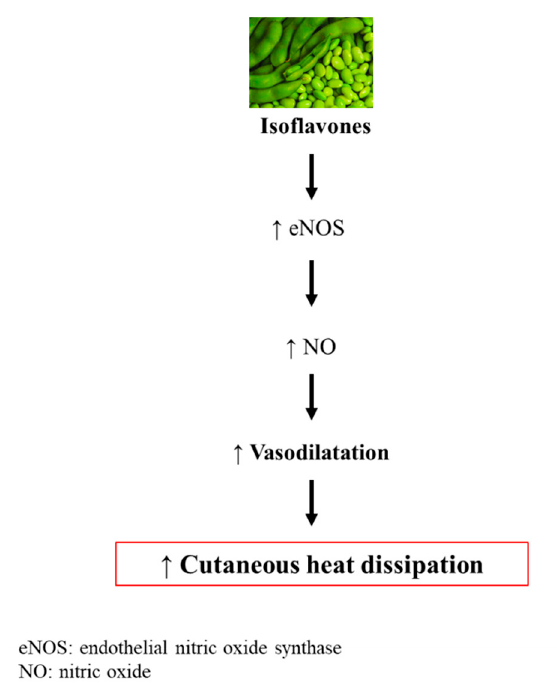
Figure 6. Possible mechanism of action of isoflavones for menopausal symptoms.